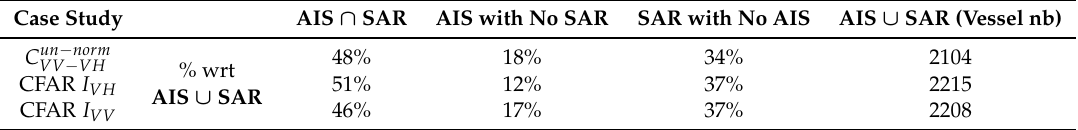
Table 4. SAR detections, i.e., C un − norm , CFAR I VH and CFAR I VV , and AIS positions global VV − VH cross-comparison for the English Channel case